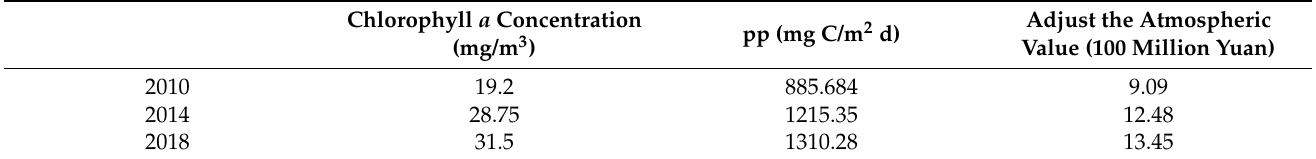
Table 9. Taihu Lake regulating air service value during